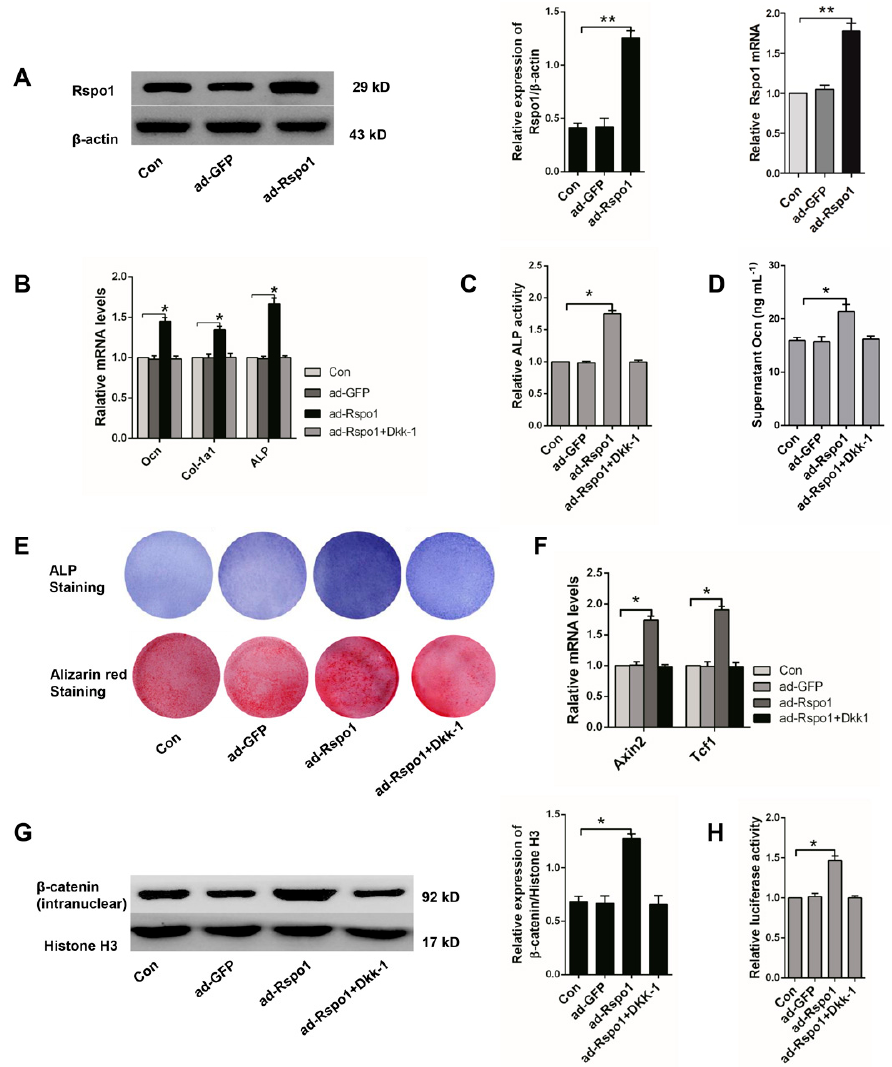
Figure 3. Overexpression of Rspo1 enhanced osteogenic differentiation of BMSCs via the Wnt/ β -catenin signaling pathway. ( A ) Western blot and qRT-PCR analysis of Rspo1 after adenovirus infection; ( B ) qRT-PCR analysis of osteogenic differentiation markers Ocn , Col-1a1 and ALP (Day 3); ( C ) Relative ALP activities (Day 3); ( D ) ELISA measurement for supernatant Ocn (Day 3); ( E ) Representative images of ALP staining (Day 7) and Alizarin red staining (Day 12); ( F ) qRT-PCR analysis of the Wnt target genes Axin2 and Tcf1; ( G ) Western blot analysis of the intranuclear level of β -catenin and ( H ) Topflash dual-luciferase activity assay of BMSCs after 24 h of osteogenic differentiation. The luciferase activities were presented as fold changes normalized to Renilla compared to Con group cells. All data were confirmed by three repeated tests and presented as the mean ± SD, * p < 0.05, ** p < 0.01. p -Values are based on ANOVA and post hoc analysis. ad-GFP: blank adenovirus with green fluorescent protein; ad-Rspo1: adenovirus with overexpressed Rspo1.